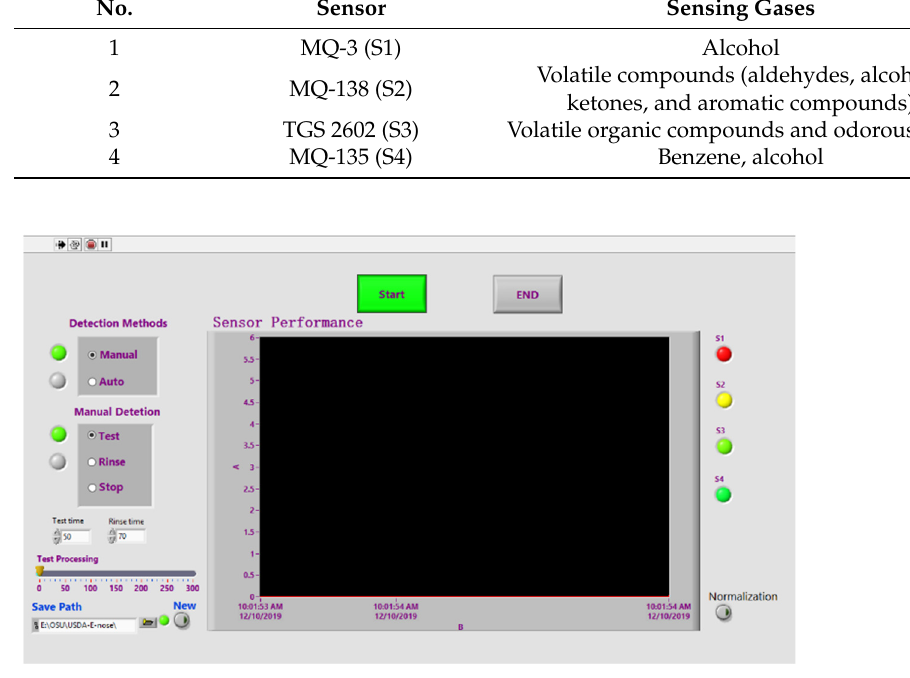
Figure 2. Interface panel of the developed E-nose system.